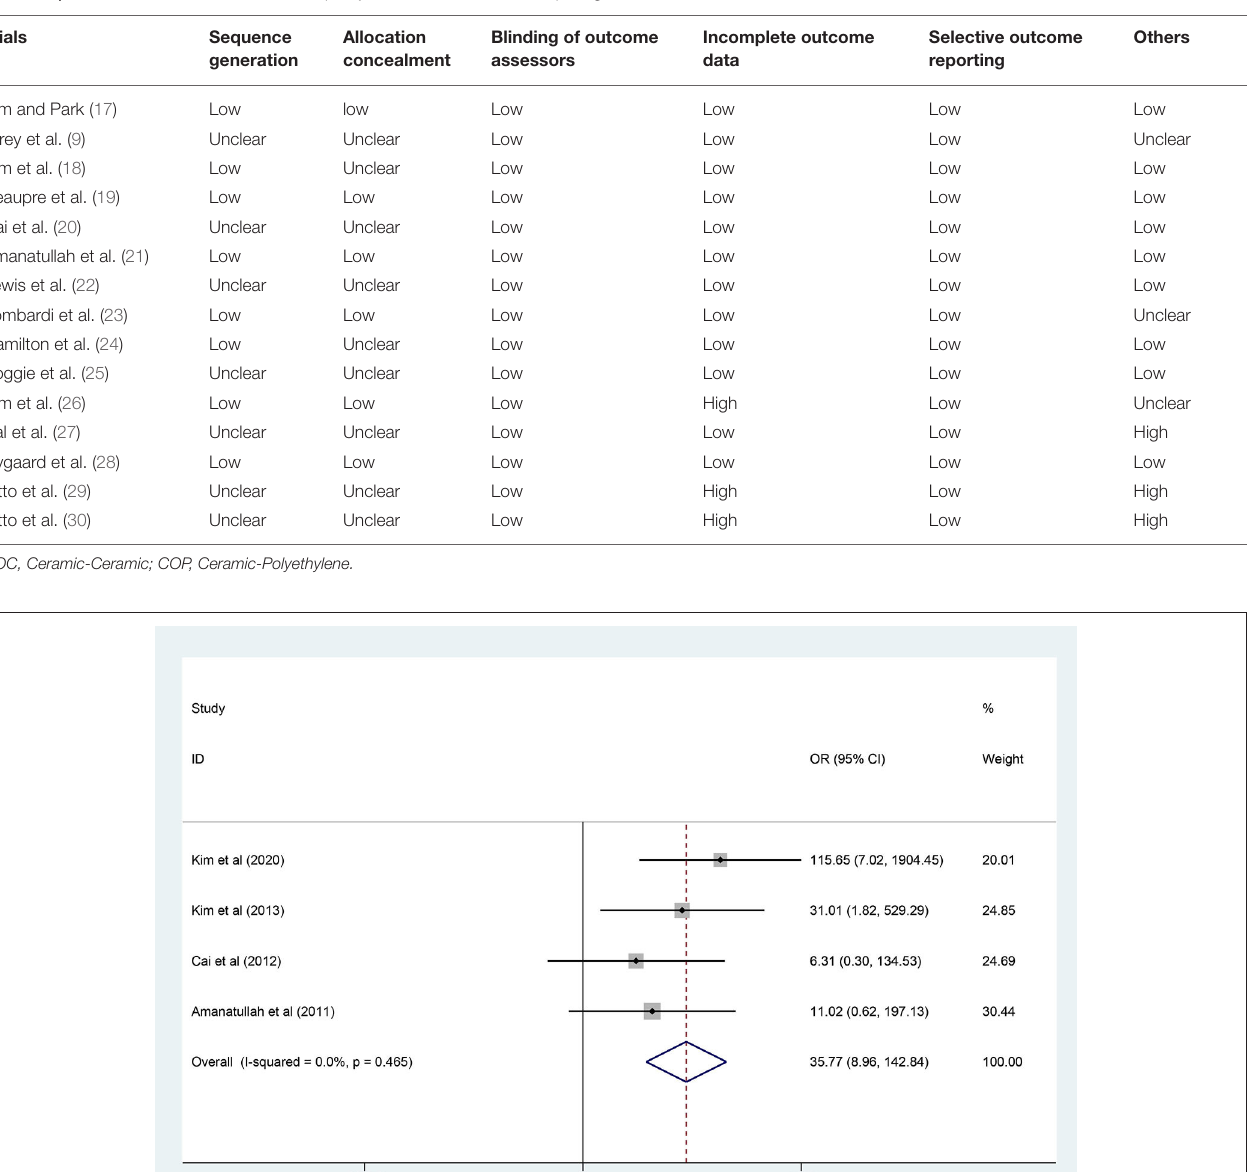
TABLE 3 | Cochrane Collaboration’s tool for quality assessment in trials comparing COC to COP.